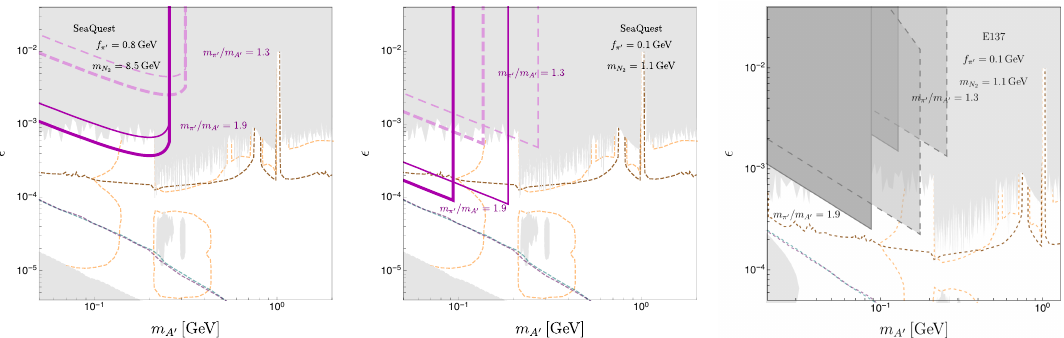
Figure 12 . Sensitivity plots and exclusion plots for dark pion searches, including variation of productions at SeaQuest and E137. We take f = 0 . 8 GeV (left) and f = 0 . 1 GeV (middle) for π 0 π 0 the sensitivity of SeaQuest, while f = 0 . 1 GeV for the exclusion limit from E137 (right). We take π 0 the different values of m : m = 1 . 9 (solid boundaries) and m = 1 . 3 (dashed π 0 /m A 0 π 0 /m A 0 π 0 /m A 0 boundaries). For the SeaQuest plots, we take the production part to be ten times smaller than that used in the text, which is illustrated as thin lines in the figure. For the E137 plot, we again take the production part to be ten times smaller than that used in the text, which is illustrated as dashed-black lines in the